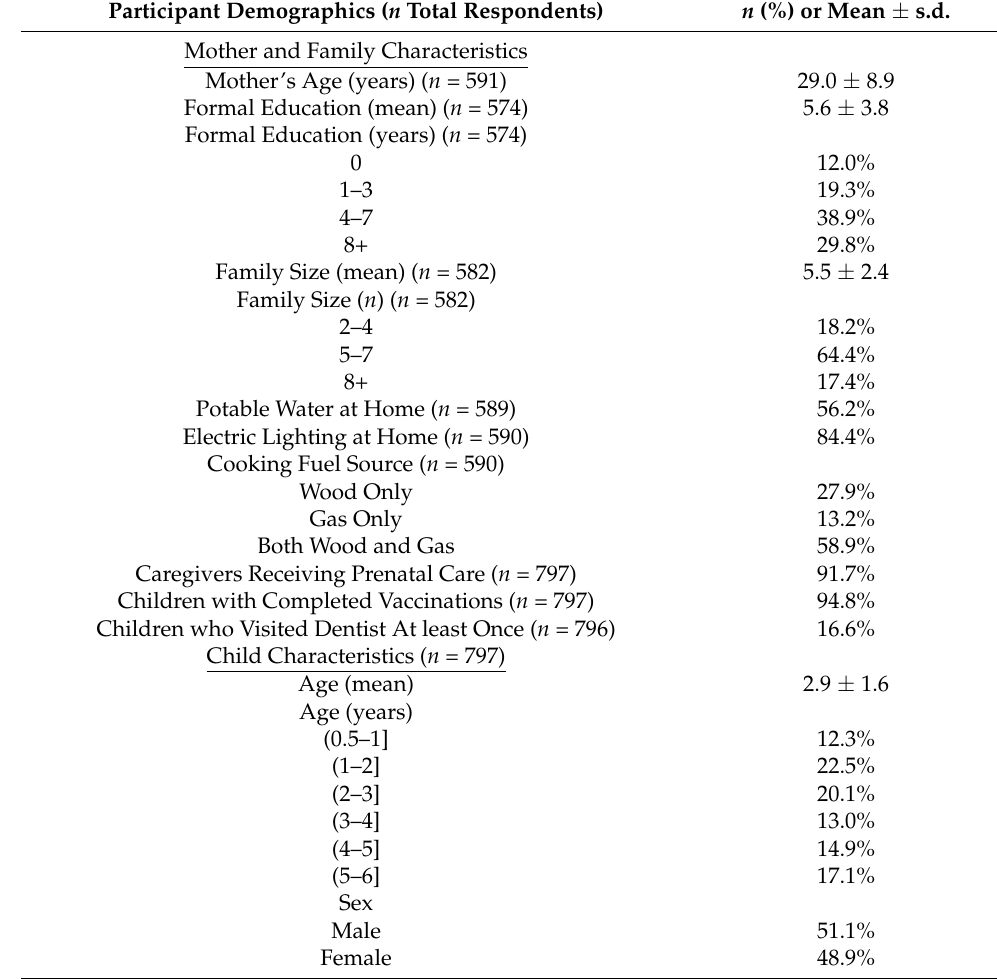
Table 1. Mother–child participant